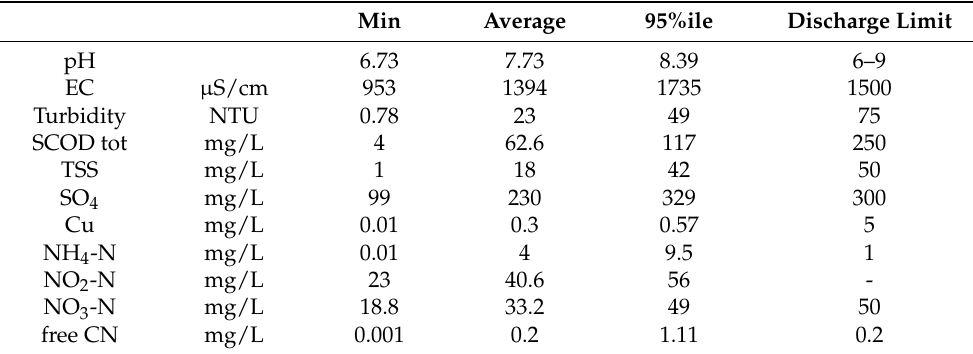
Table 4. Characteristics of pilot plant influent